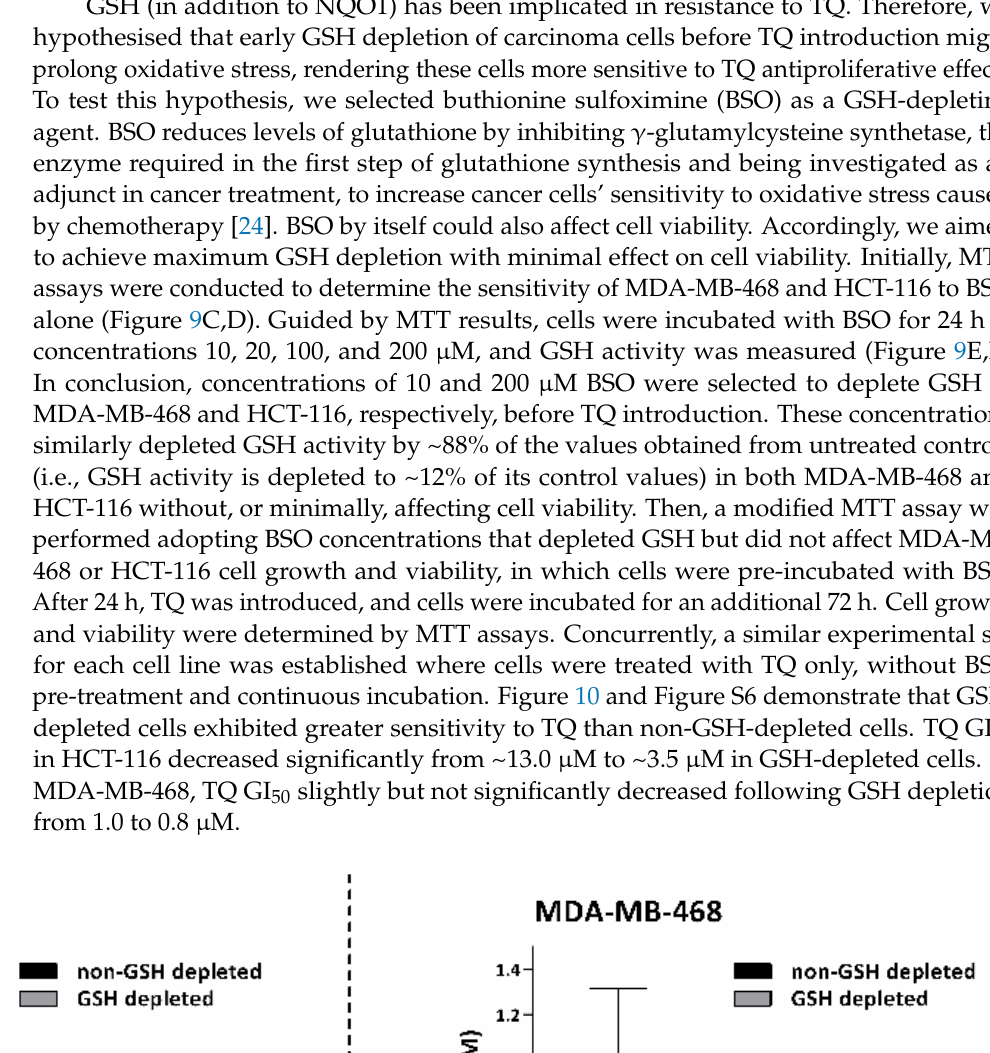
in MDA-MB-468 and HCT- 50